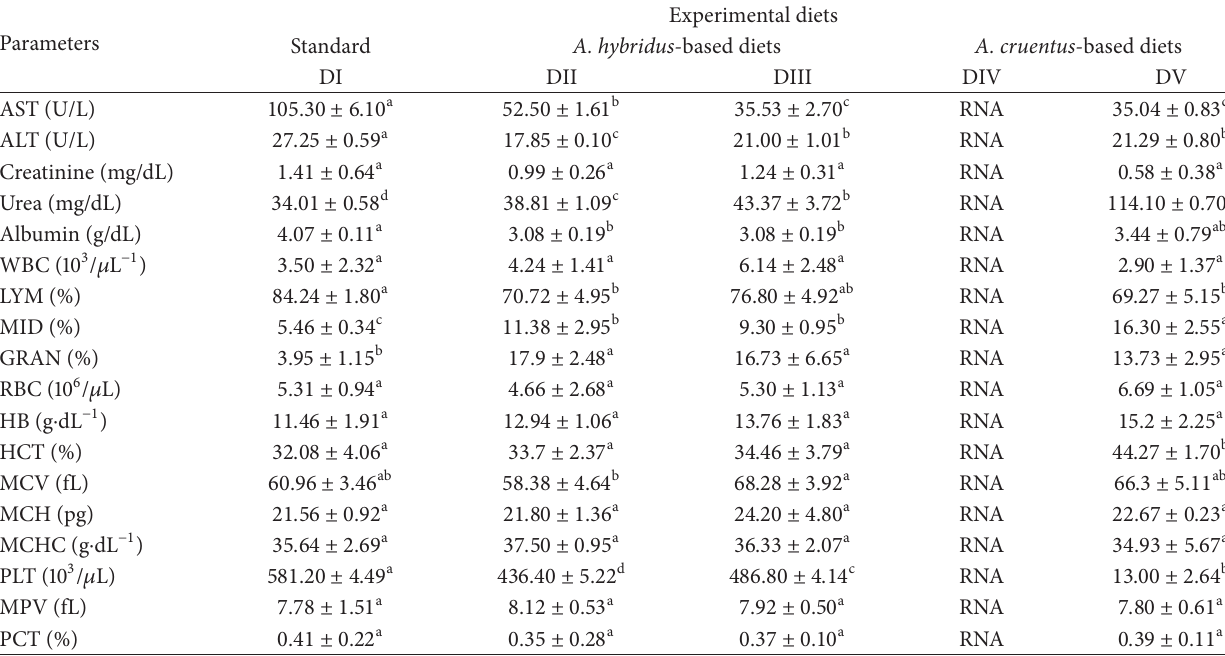
Table 5: Biochemical parameters and haematological indices of rats fed with different processed A. hybridus and A. cruentus meal.